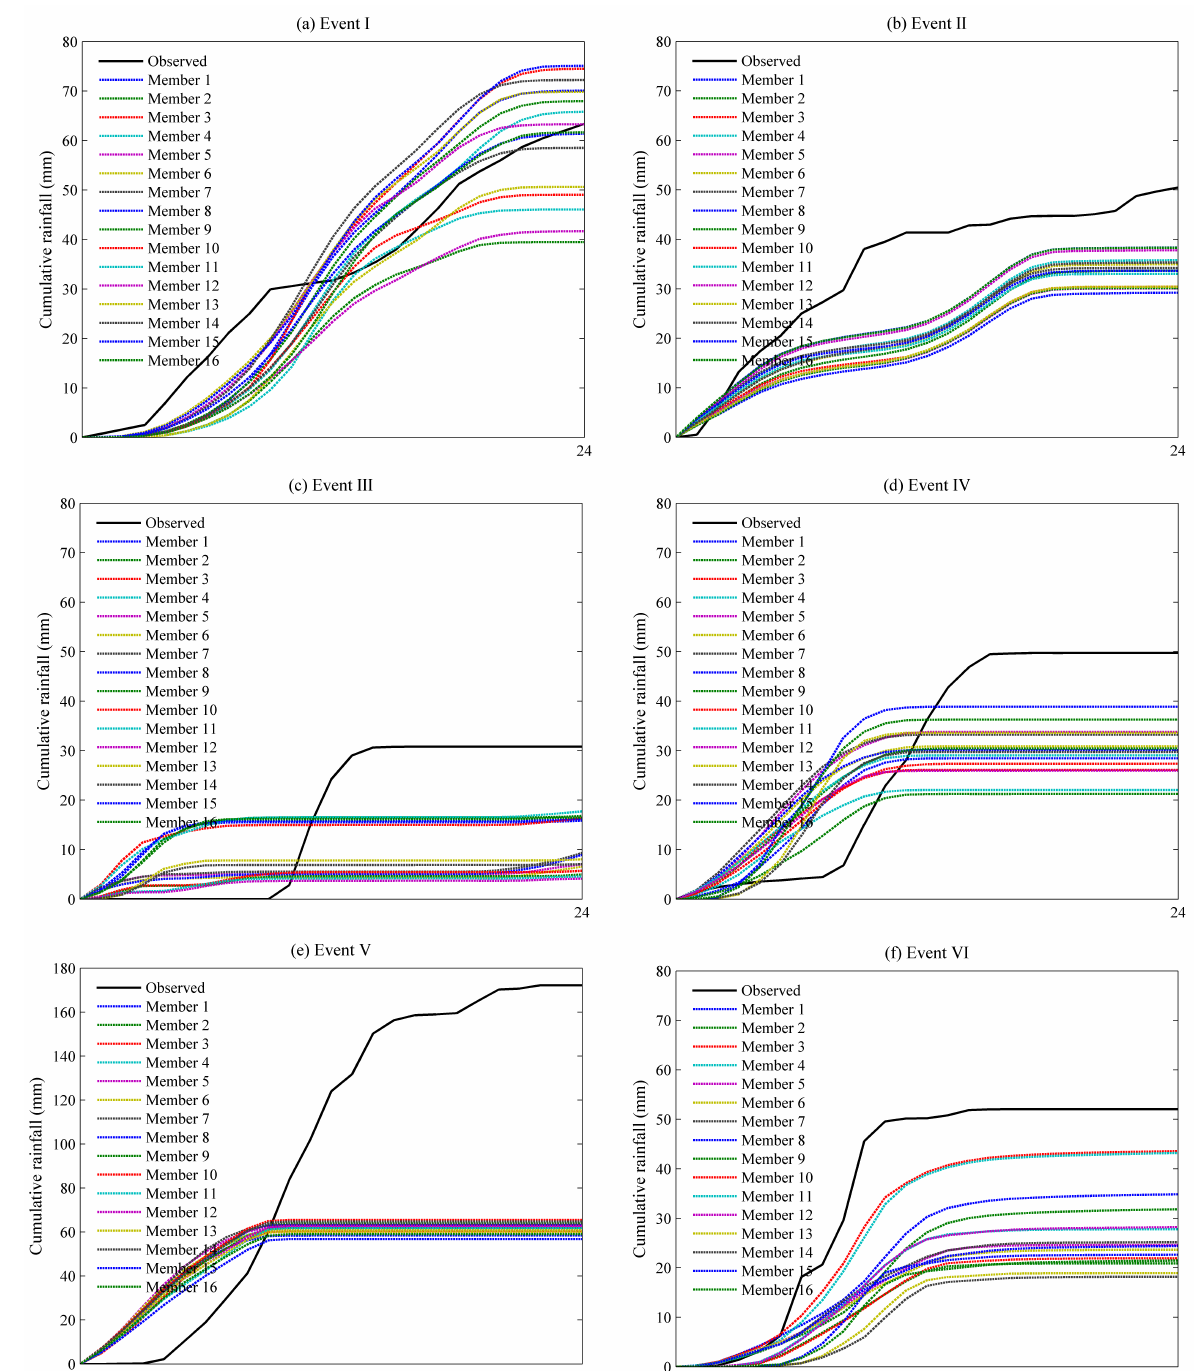
Figure 3. Cumulative curves of the observed and simulated areal rainfall for the six storm